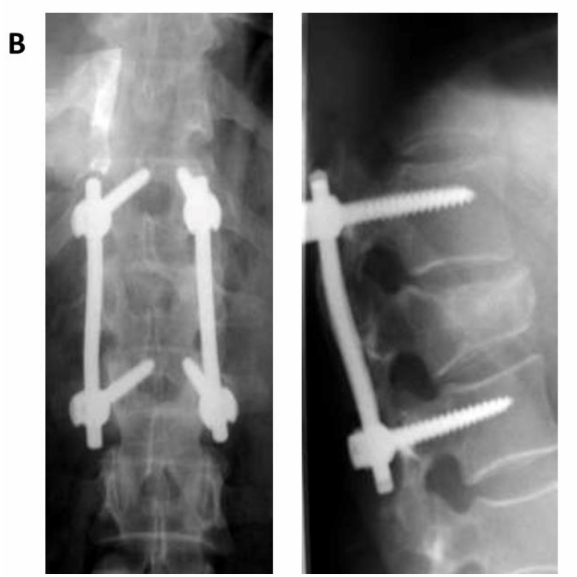
Figure 1. Postoperative X-ray showing a long segment pedicular screws ( A ) and short segment pedicular screws ( B